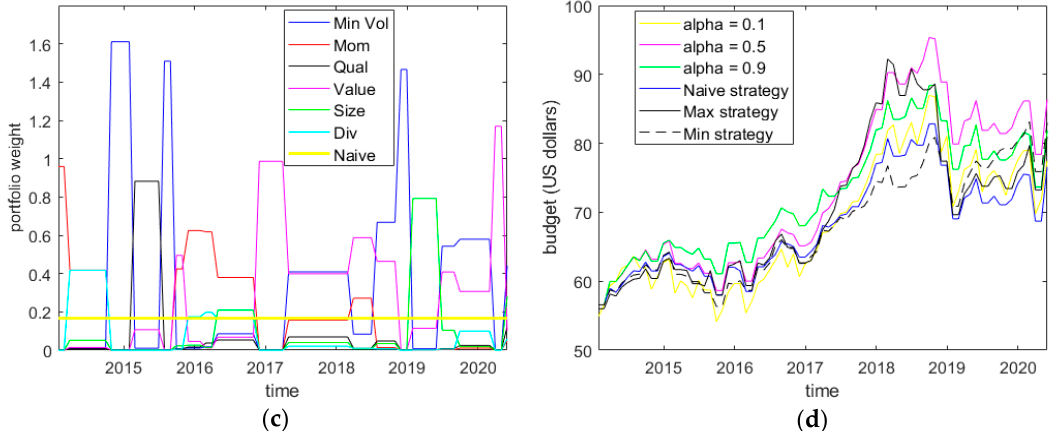
Figure 3. Portfolio optimal weights for α equal to 0.1 ( a ), 0.5 ( b ), 0.9 ( c ), and portfolio performances (budget expressed in US dollars) for all strategies considered ( d ) from January 2014 to May 2020. Source: our elaboration on data.